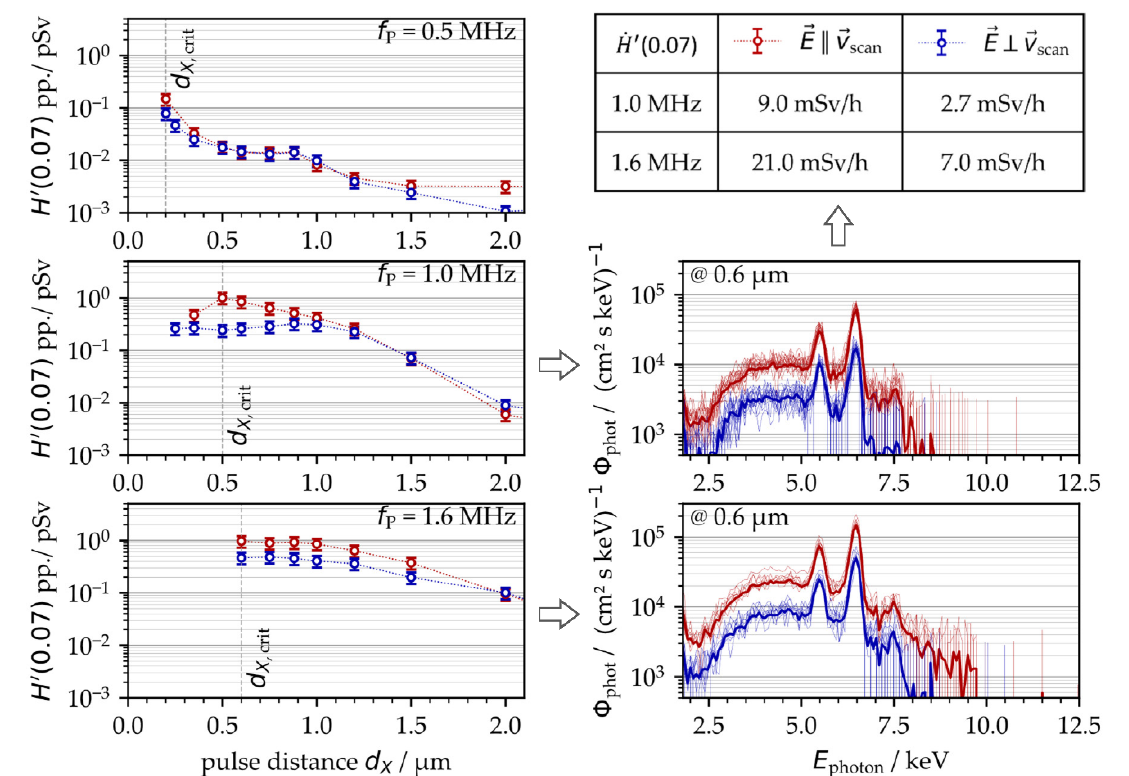
Figure 7. ( Left ): X-ray emission dose per pulse as a function of pulse distance, PRF, and polarization direction at a 2.8 m/s ± 0.4 m/s suction flow speed; ( right ): corresponding X-ray photon spectra monitored for 1.0 MHz or 1.6 MHz PRF, 0.6 intra-line pulse distance, 0.9 m/s ± 0.3 m/s suction flow speed, and either parallel (red) or perpendicular (blue) laser beam polarization.